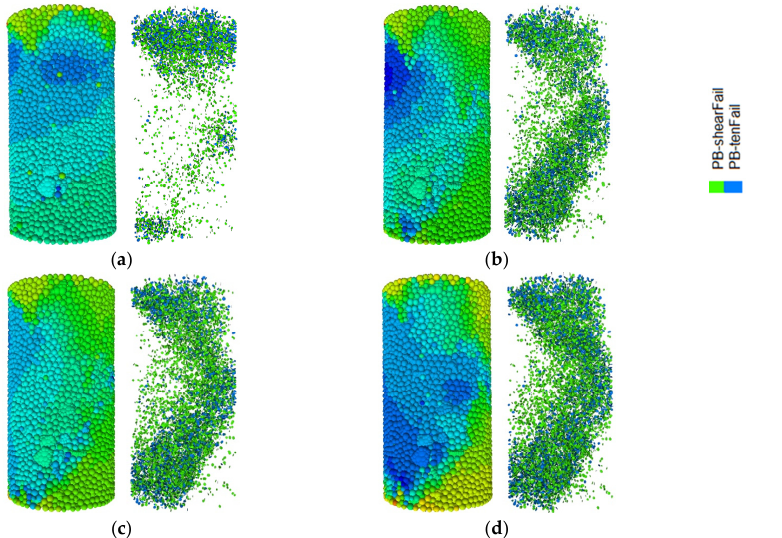
Figure 14. Damage simulation of RAC20 under different confining pressures. ( a ) 0 MPa, ( b ) 2.5 MPa, ( c ) 5 MPa, ( d ) 10 MPa.